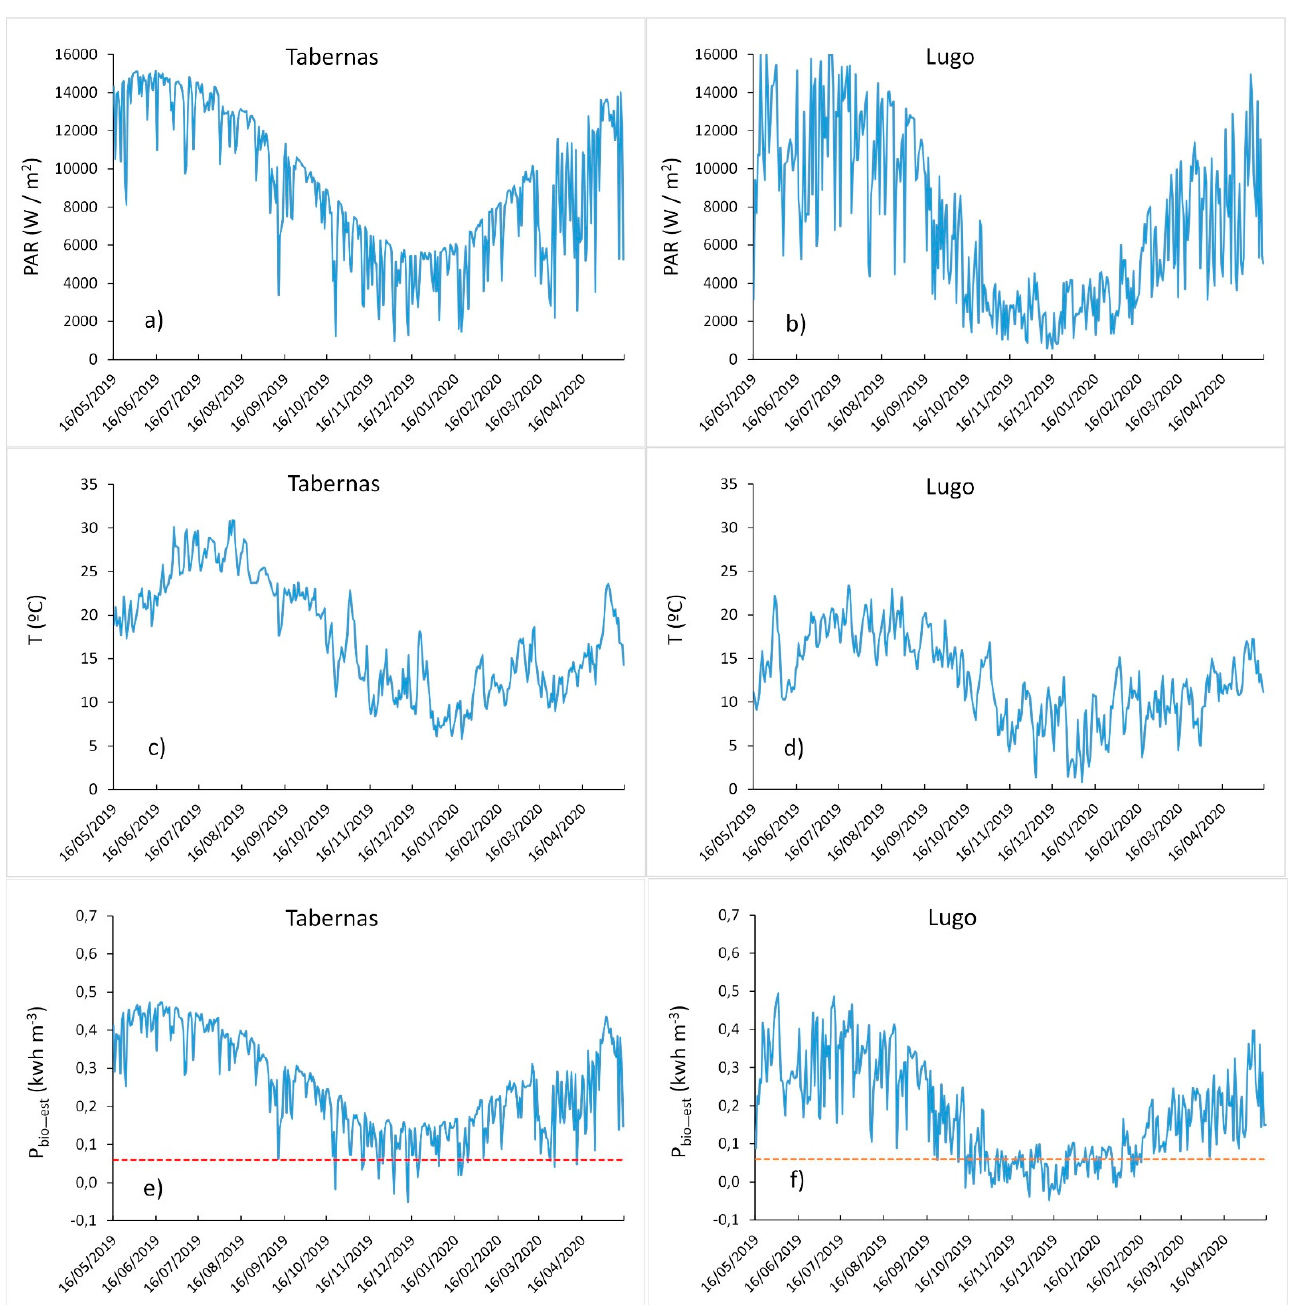
Figure 1. Temporal evolution of: PAR ( a , b ); Temperature ( c , d ); Power from biomass estimated along with HRAP energy consumption (0.06 kWh m − 3 ) ( e , f ).